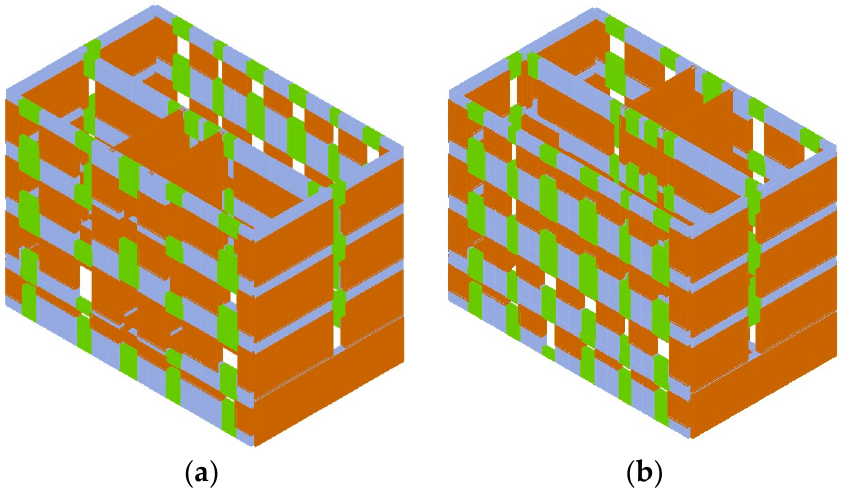
Figure 8. Macro-element models of the case study building developed with the TreMuri software: ( a ) Front view model, ( b ) Back view model. Indeed, in Figure 9 the three–dimensional model of the building structure obtained using the TreMuri software is illustrated.